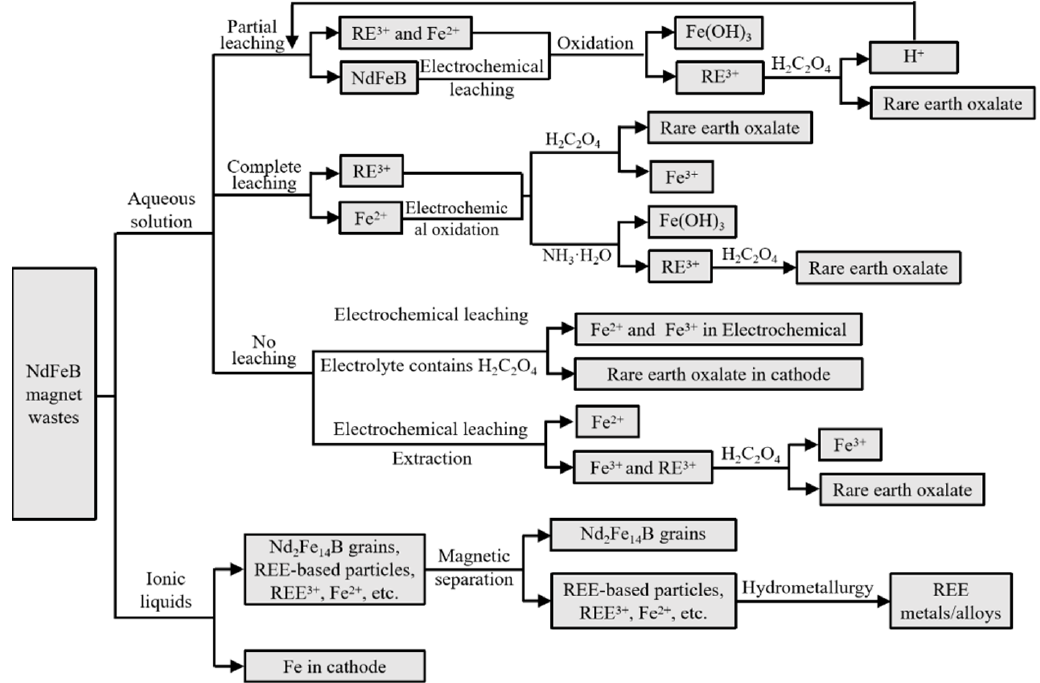
Figure 8. Flow chart of typical techniques for the electrochemistry of NdFeB magnet wastes.